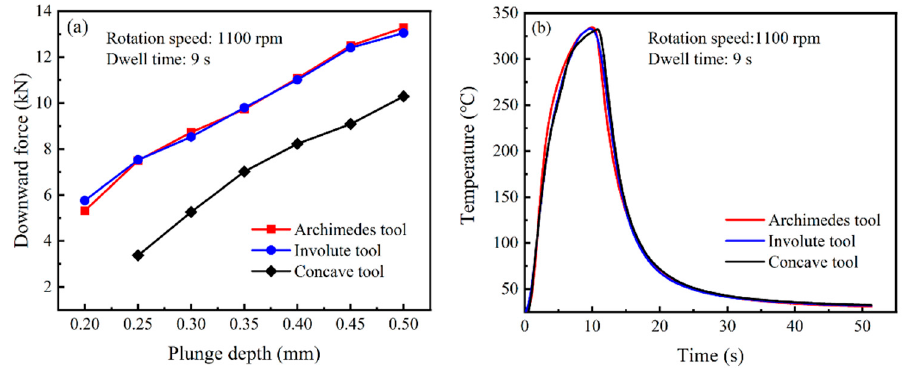
Figure 4. ( a ) Relationship of plunge depth with downward force; ( b ) temperature variations during the processing.